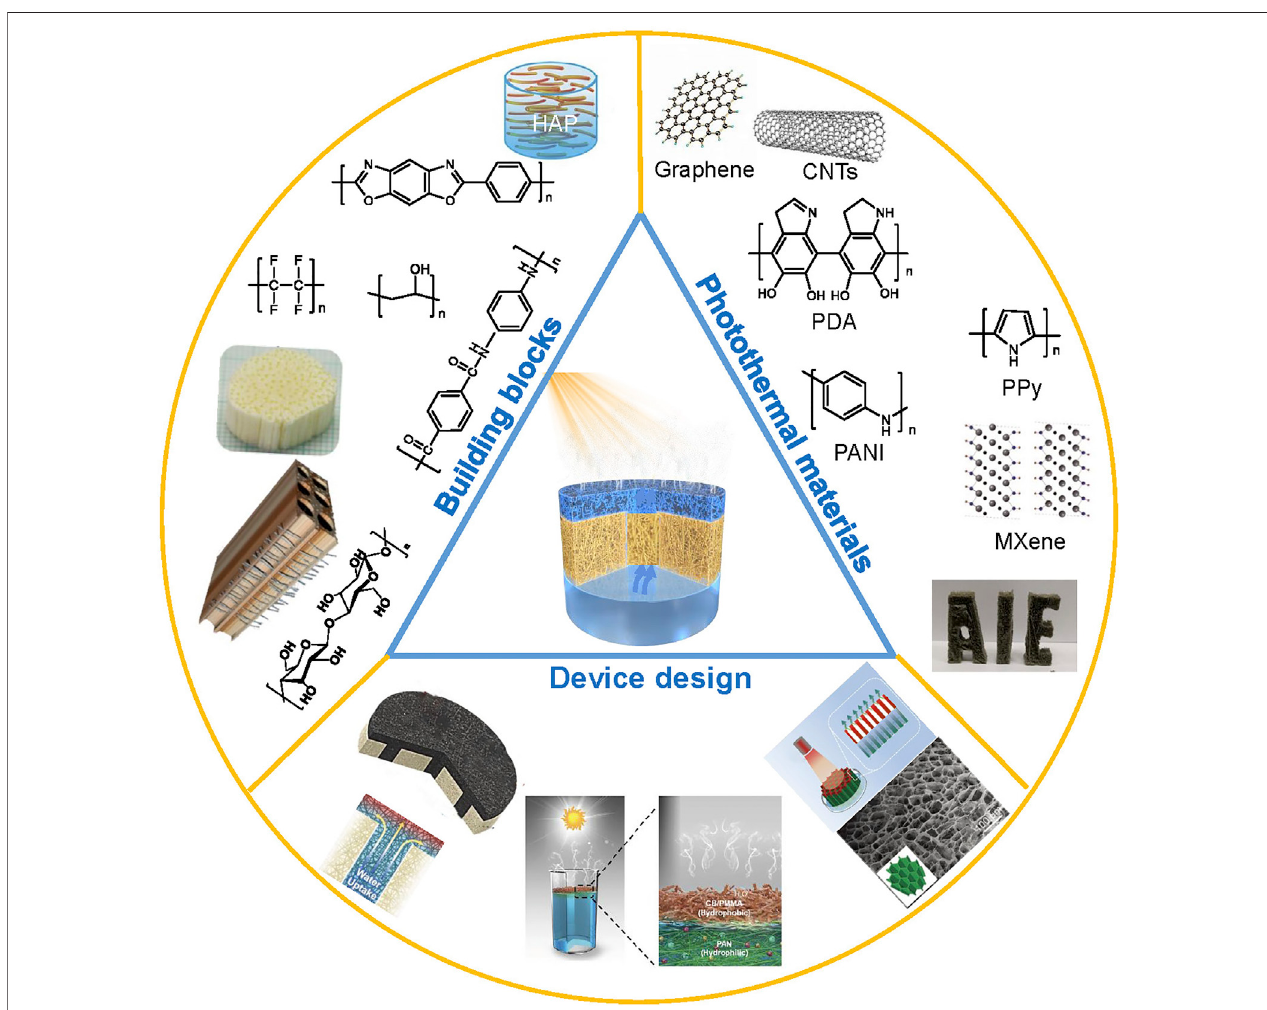
FIGURE 1 | Schematic showing the key sections of fi brous aerogels fabrication for solar vapor generation described in this review. Building blocks synthesis, photothermal materials selection, porous structures construction and devices design are reviewed. Reprinted with permission from (Zhang Q. et al., 2020). Copyright (2020) American Chemical Society. Reprinted with permission from (Li J. et al., 2020). Copyright (2020) American Chemical Society. Reprinted with permission from (Zhang et al., 2018). Copyright (2018) American Chemical Society. Reprinted with permission from (Gao T. et al., 2019). Copyright (2019) WILEY VCH.